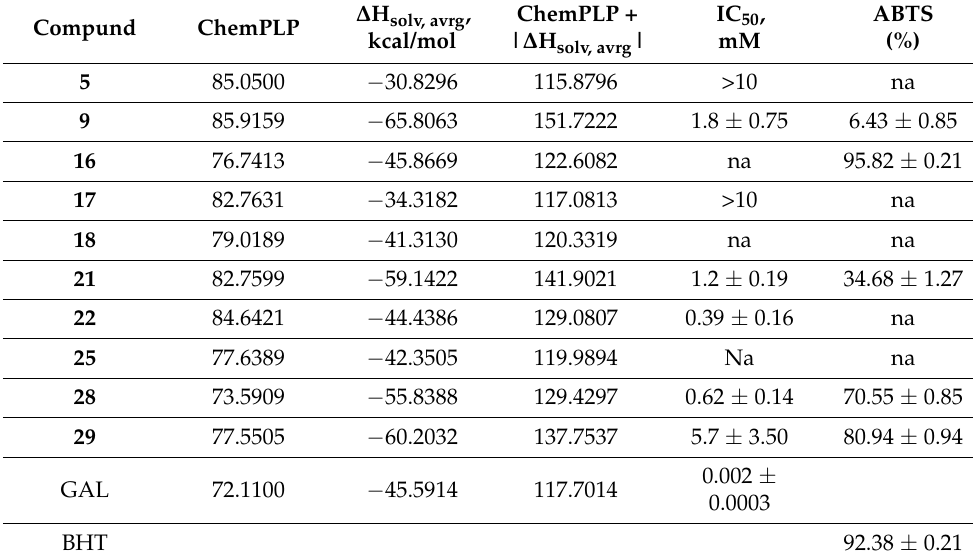
Table 1. ChemPLP score, ∆ H solv,avg , sum of their modules, and anti-AChE and antioxidant activities of the selected NCs are presented. GAL is the reference AChE inhibitor and butylhydroxytoluene (BHT) is the reference antioxidant. The IC50 and ABTS values were measured in triplicate, and the results are presented as means ±